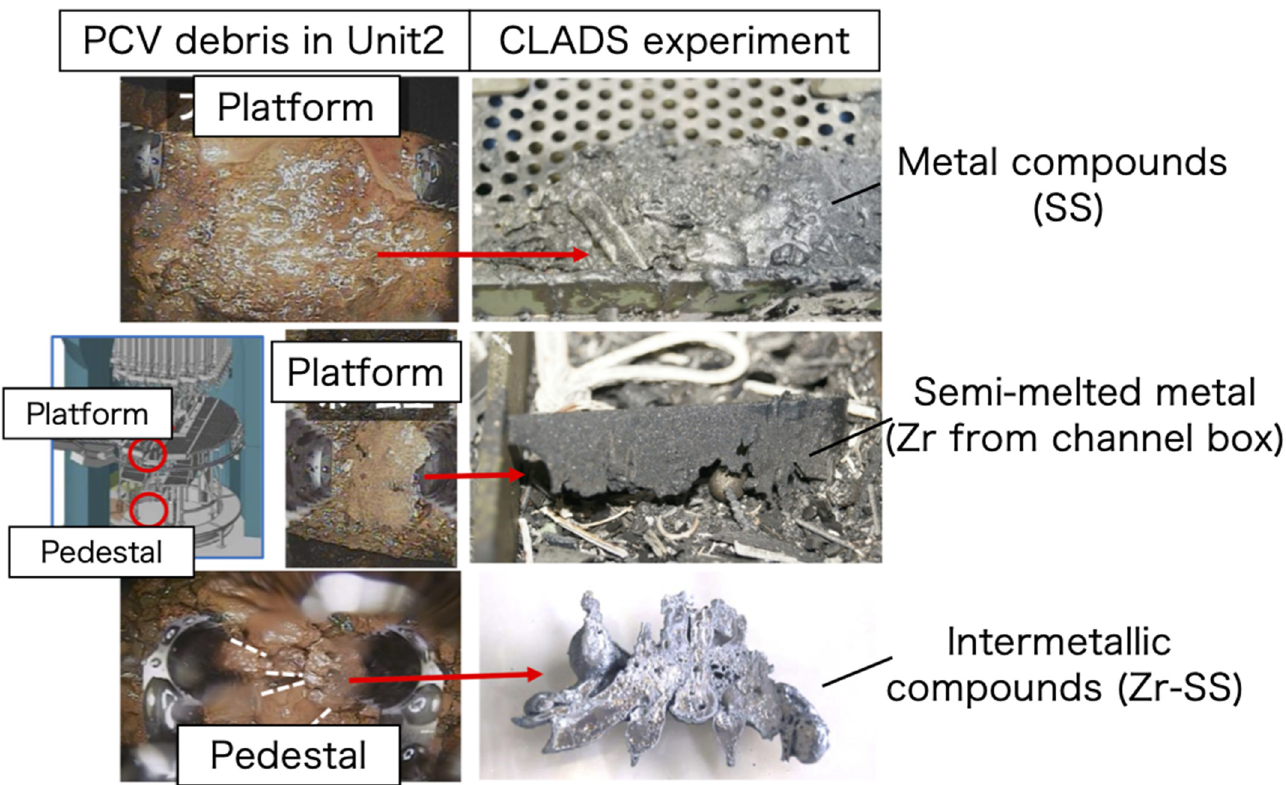
Figure 16. Summary of fuel debris in Unit 2 and the results of large-scale experiments from CLADS [1–3,46].